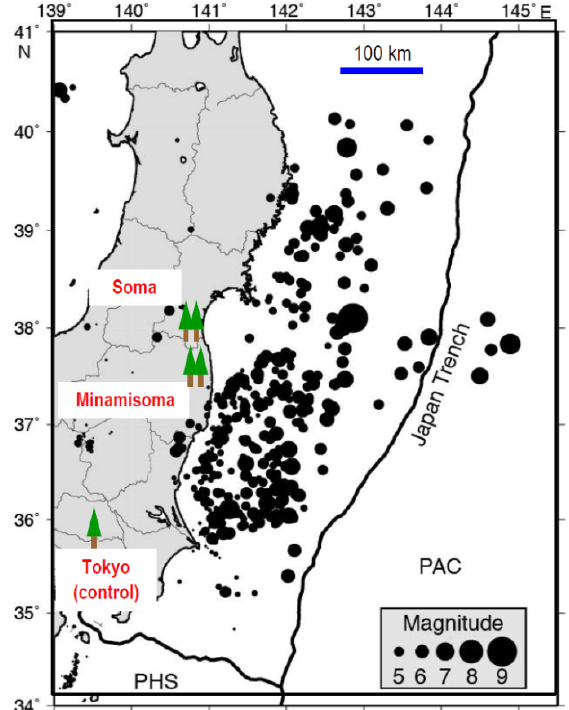
Figure 1. Three sites of tree sampling in Japan. Soma and Minamisoma were selected close to the hypocenter location of the mainshock and aftershocks exceeding a magnitude of 5 (black circles) within 24 h of the 11 March 2011 megathrust earthquake in northeast Japan. Tokyo was used as a control.